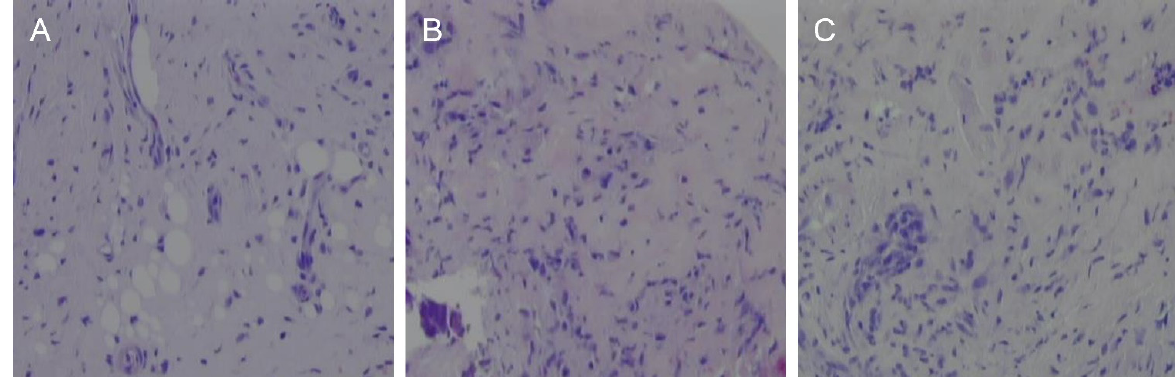
Figure 4. The inflammatory cell infiltration was higher in the H&E-stained samples of the rat palate from the laser A ( B ) and laser B ( C ) groups than those from the rats exposed to the scalpel wound ( A ) 3 days after surgery. Table 1. Result of histologic and immunohistochemical analyses.